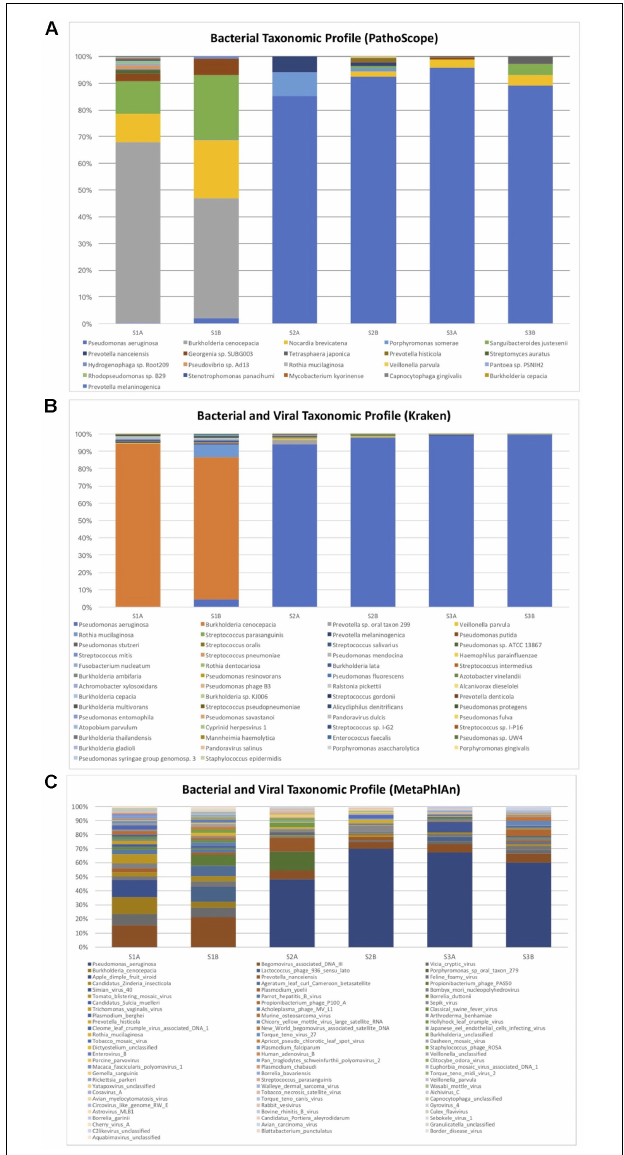
FIGURE 1 | Bacterial and viral taxonomic profile of pre- and post-antibiotic sputum samples in three subjects with cystic fibrosis who grew antibiotic resistant bacteria. Only bacterial and viral species with a minimum total observation count of 0.01% of total reads are shown for PathoScope (A) and Kraken (B) . Only bacterial and viral species with a minimum total observation count of 0.1% of total reads are shown for MetaPhlAn (C) . Burkholderia cepacia was the pathogen identified in culture for subject S1, but the majority of reads were attributed to Burkholderia cenocepacia. Pseudomonas aeruginosa was identified as the predominant bacteria for subjects S2 and S3, and was also identified in corresponding respiratory